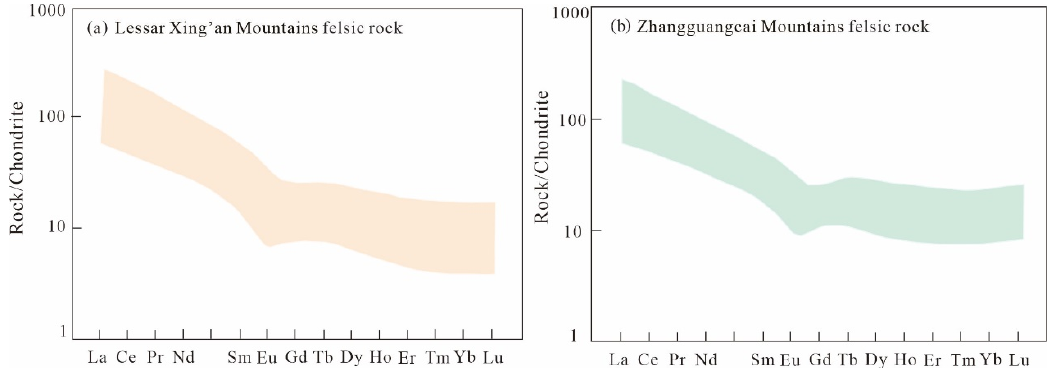
Figure 11. Distribution of rare earth elements in felic rocks in the Xiaoxing’anling and Zhangguangcailing areas (after [7,56–62]). ( a ) Lessar Xing’an Mountains felsic rock, ( b ) Zhangguangcai Mountains felsic rock.